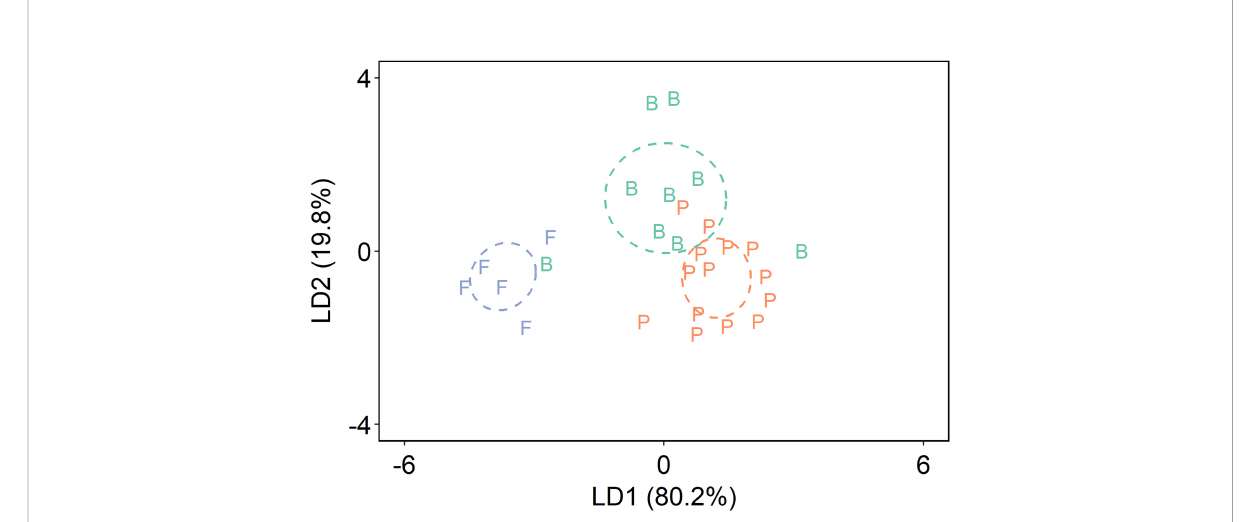
FIGURE 5 Linear discriminant analysis based on normalized d 13 C values of fi ve essential amino acids of pelagic algae (P) and sea ice algae from the fast ice (F) and brash ice (B). Values in parentheses of the axis titles are the percentage variation explained by each axis. The colored ellipses represent standard ellipse area (SEA) for each corresponding group, containing ~40% of the